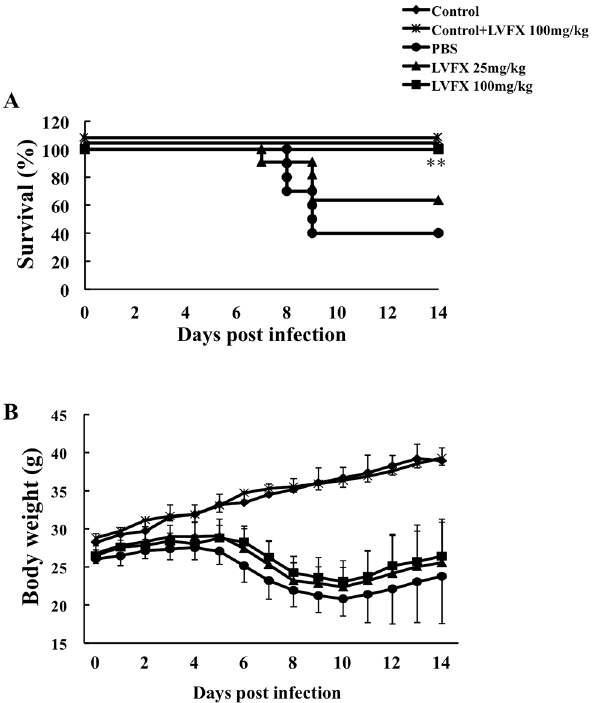
Fig 2. Therapeutic effect of LVFX on influenza virus-infected mice. Influenza virus infected mice were produced by the intratracheal administration of influenza virus under anesthesia on day 0. After infection, the mice were treated with LVFX on day 2 after infection by means of an intraperitoneal injection of LVFX. (A) Survival curves for control (n = 3), 100 mg/kg LVFX (not infected, n = 3), PBS (n = 10), 25 mg/kg LVFX (n = 10) and 100 mg/kg LVFX (n = 10) treatment during an influenza virus infection. (B) Weight loss during an influenza virus infection. Each bar represents the mean ± SD. ** p < 0.01 vs vehicle. Experiment was repeated three